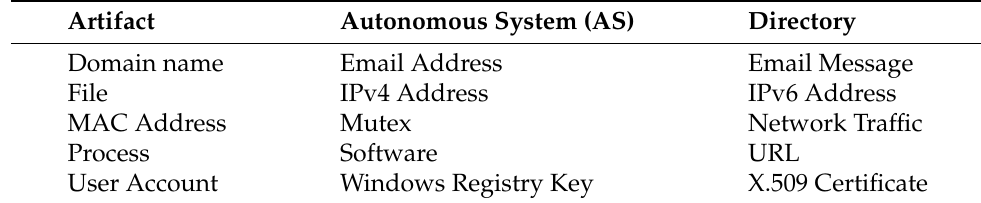
Table 1. STIX 2.1 Cyber-observable